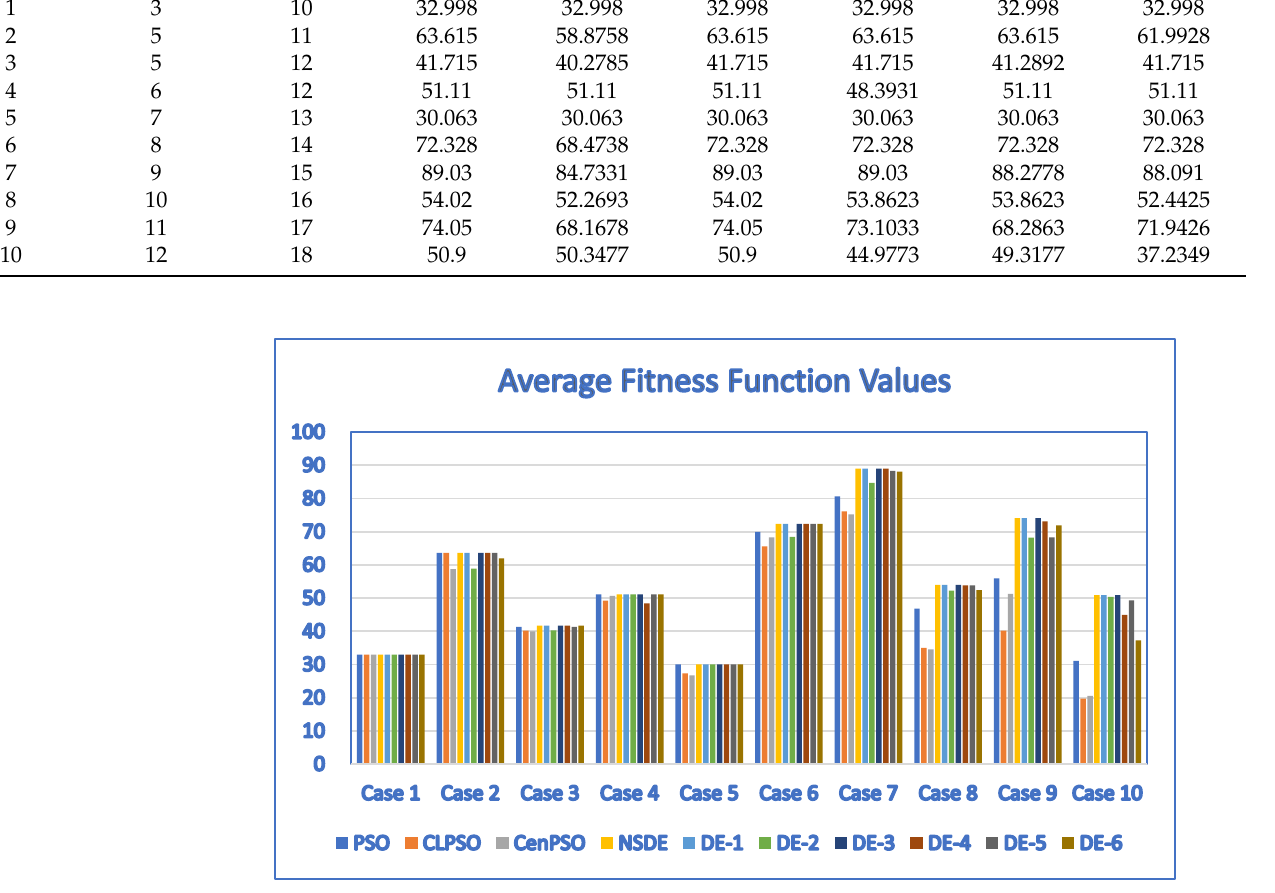
Figure 6. Average fitness function values for D r = P r =0.1 with NP = 50.